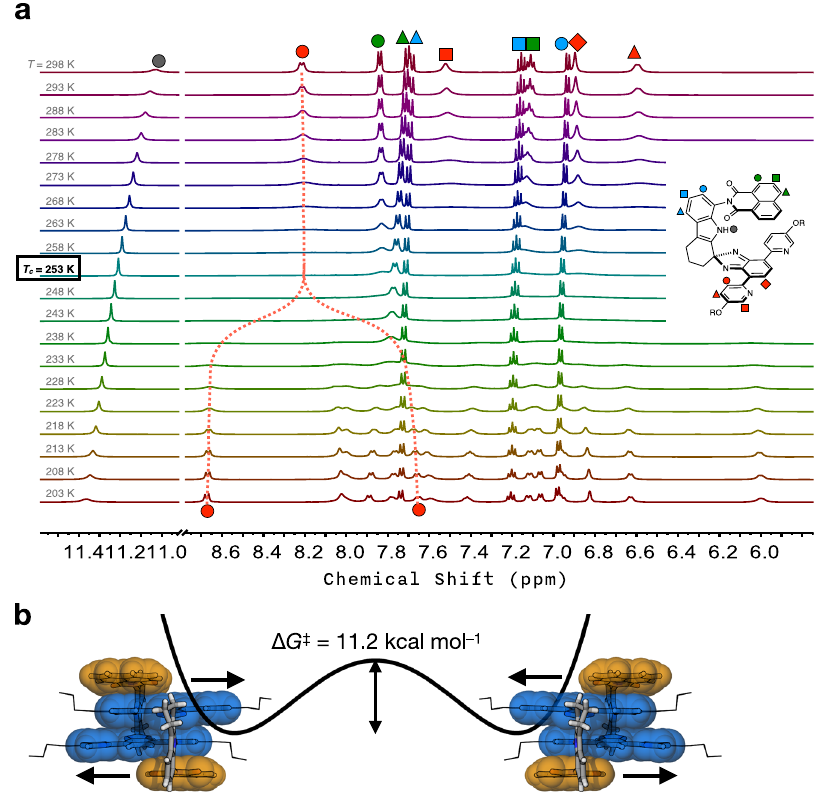
Fig. 5 Fluxional motions of quadruple π -stack. a Variable-temperature (VT) 1 H NMR (500 MHz) spectra of C-NI in CD 2 Cl 2 (9.5 mM) obtained at T = 203 – 298 K. The coalescence temperature T = 253 K was determined with the pyridine proton resonance (annotated as a red circle in the chemical c structure shown next). b Schematic representation of the lateral sliding motion and the energy barrier. NMR nuclear magnetic